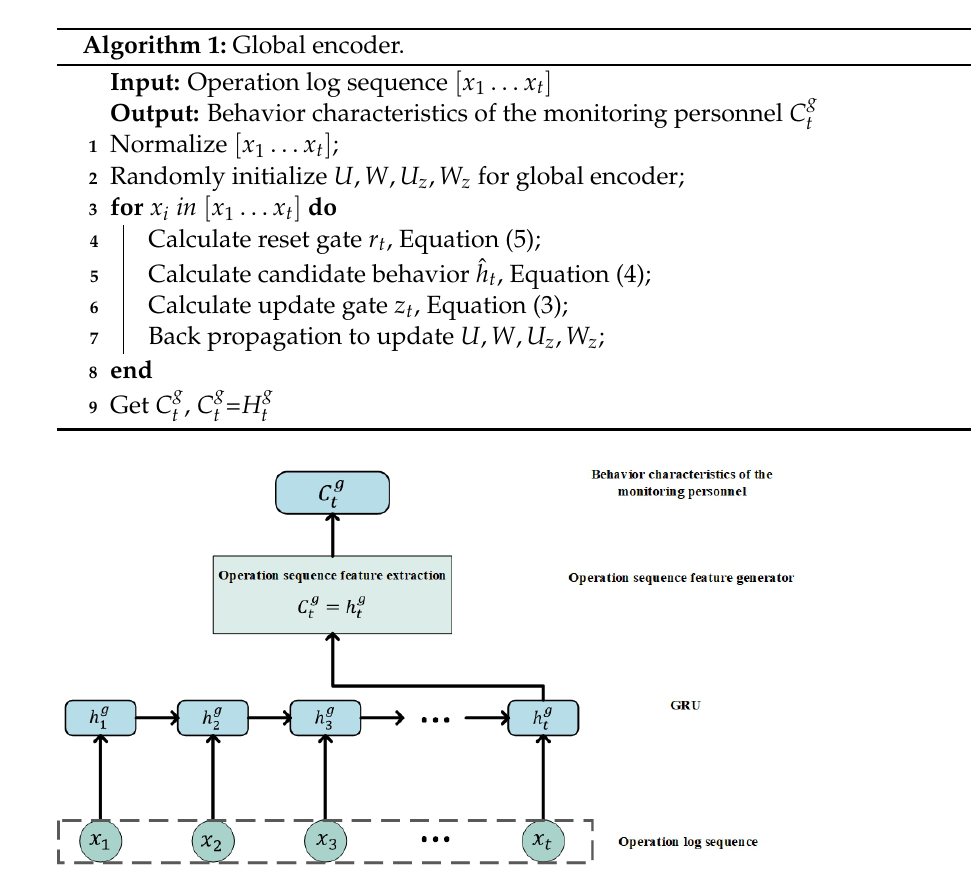
Figure 2. The global